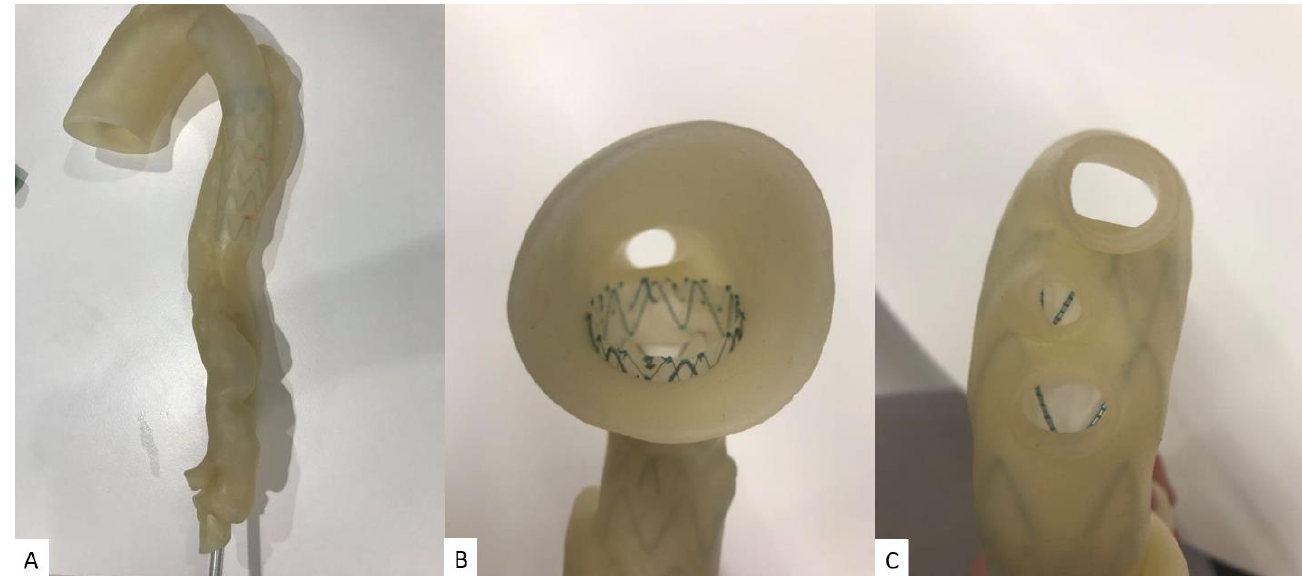
Figure 4. Three-dimensional-printed type B aortic dissection model for simulation of endovascular aortic repair of type B aortic dissection. The printing material was Visijet CE-NT A30. An aortic stent graft was placed into the true lumen of the 3D-printed model ( A ) with axial ( B ) and caudal views ( C ) showing the proximal aortic arch and vessels. Reprinted with permission under the open access from Wu et al. [46].